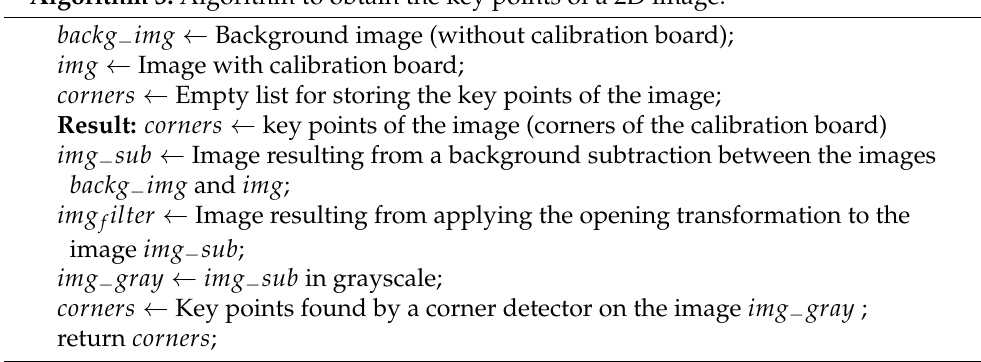
Figure 10. 3D points belonging to the calibration point, the corresponding estimated edges and the resulting key points. and a LiDAR, as presented in Equation 7. Through this relationship between the param- 257 eters of the sensors, it is possible to create a projection of the 3D points to the 2D space 258 in order to estimate the fusion of the information. 259